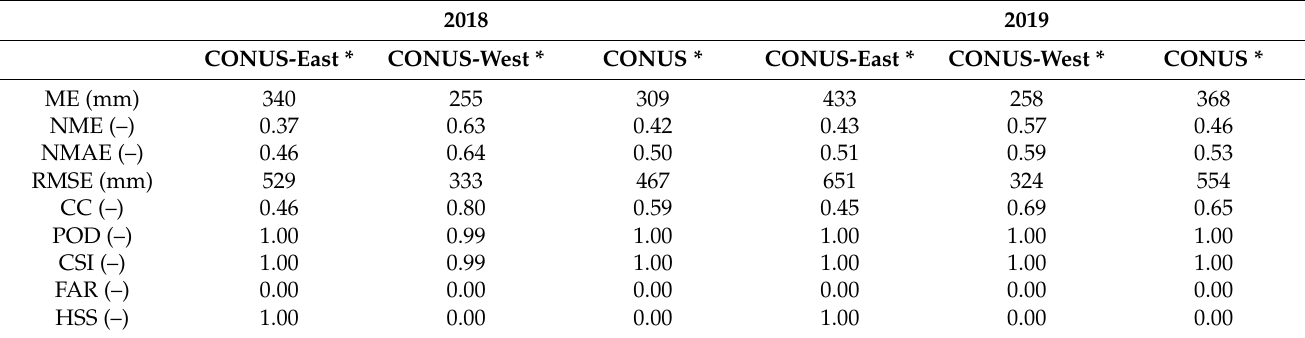
Table 1. Evaluation statistics for the GOES-16 QPE estimated warm-season rainfall accumulations in 2018 and 2019.